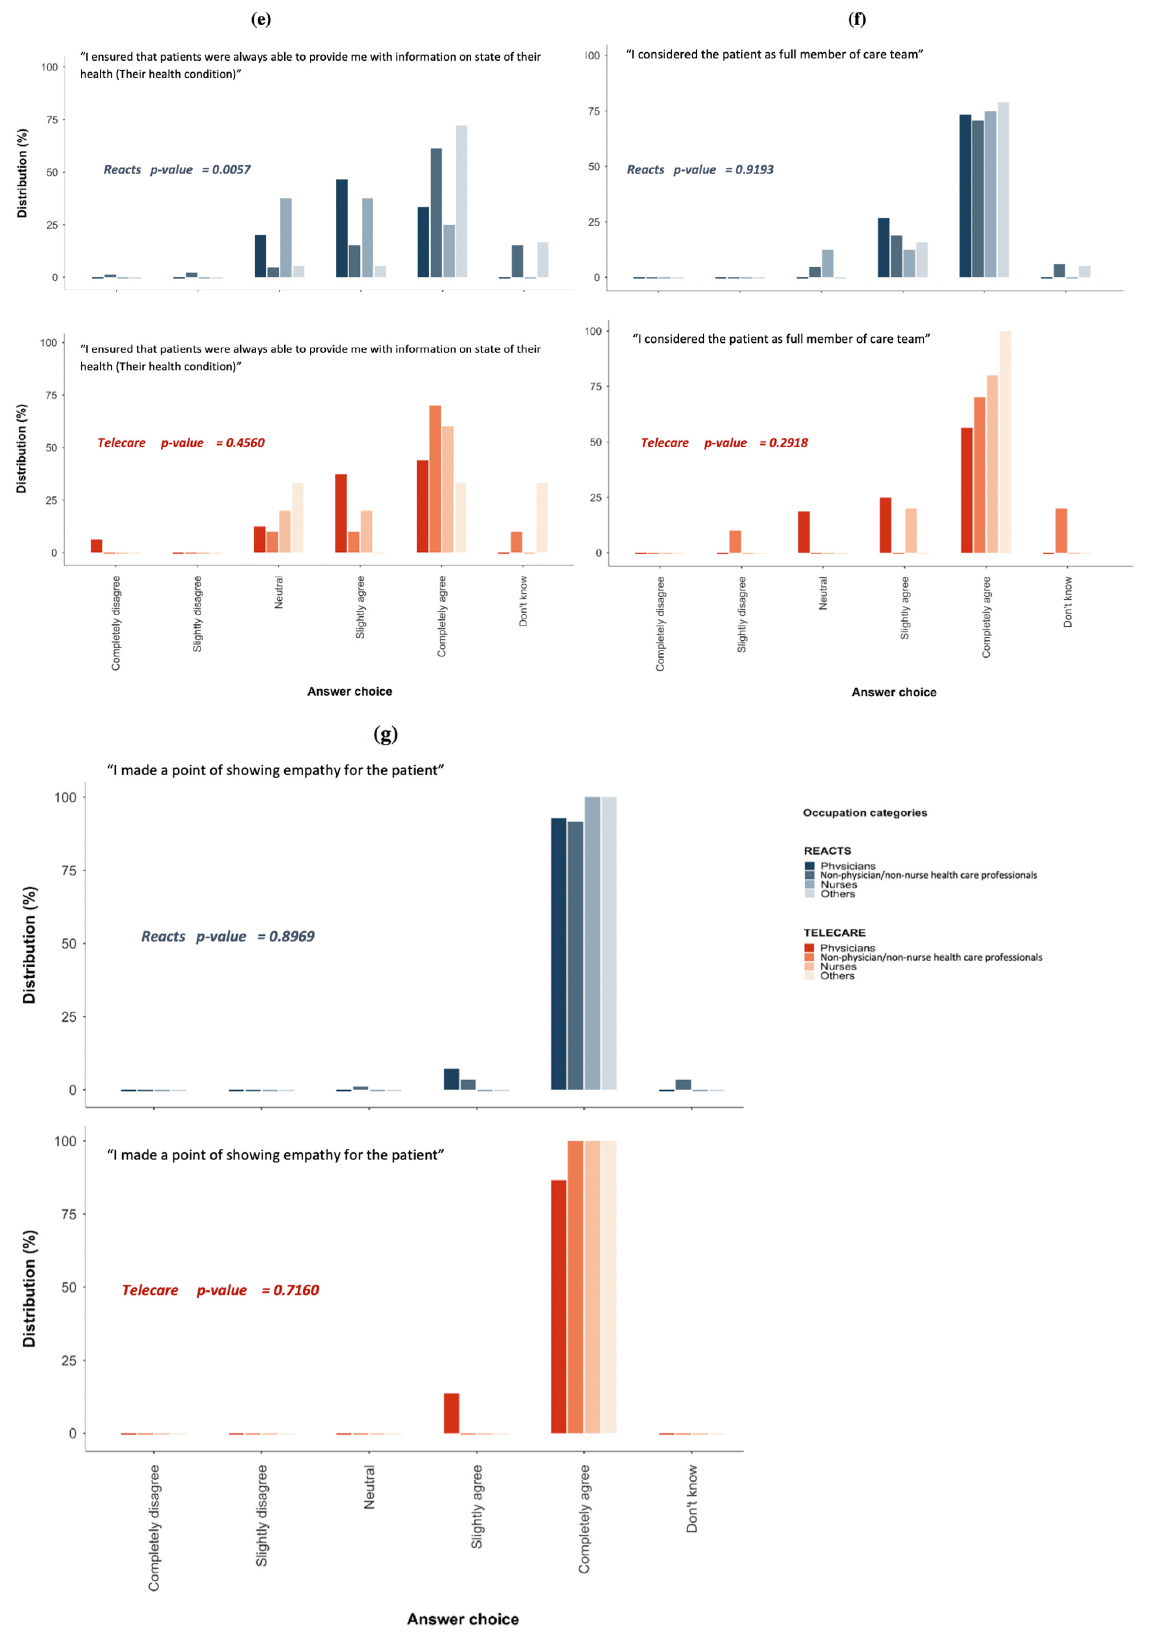
Figure 2. Perceptions of patient engagement in care and the relationship with the care team. Figure 2 ( a ). Respondents’ perception of the bond of trust and confidence created with patients provided